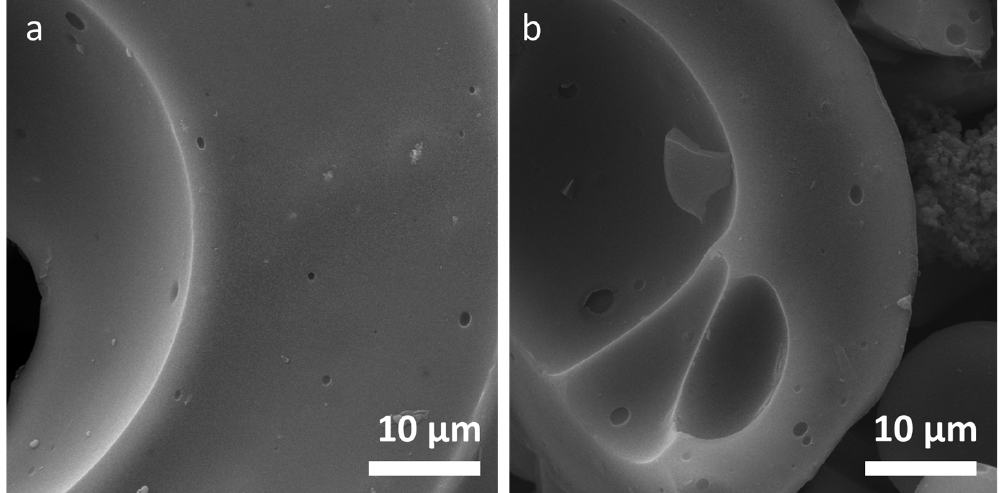
Figure 2. SEM micrographs of lignosulfonate samples, ( a ) L 250 ; ( b ) L 2000 .